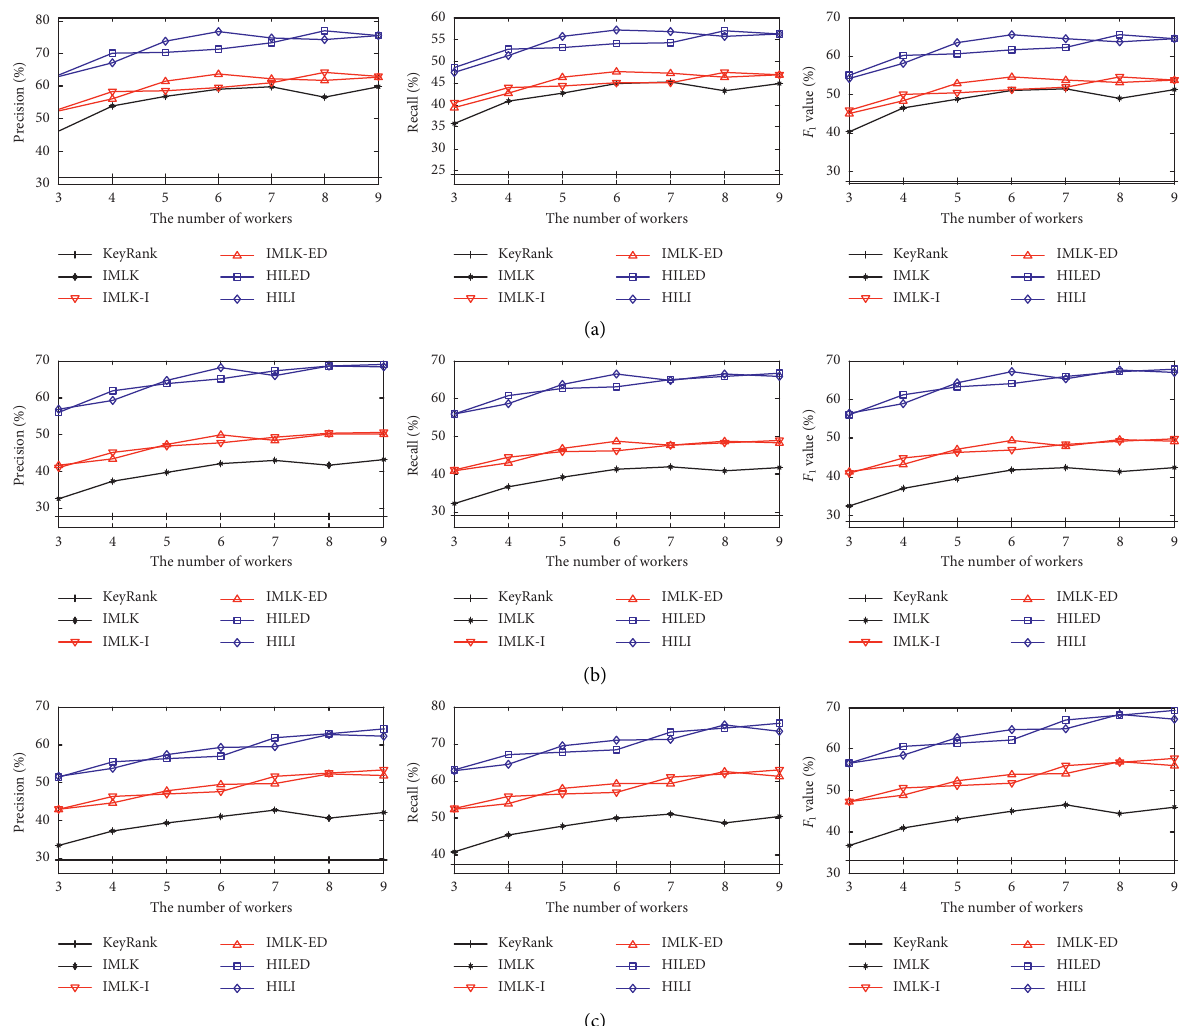
Figure 2: Comparisons among KeyRank, IMLK, IMKL-I, IMLK-ED, HILED, and HILI in all groups. (a) Group-3. (b) Group-4. (c)